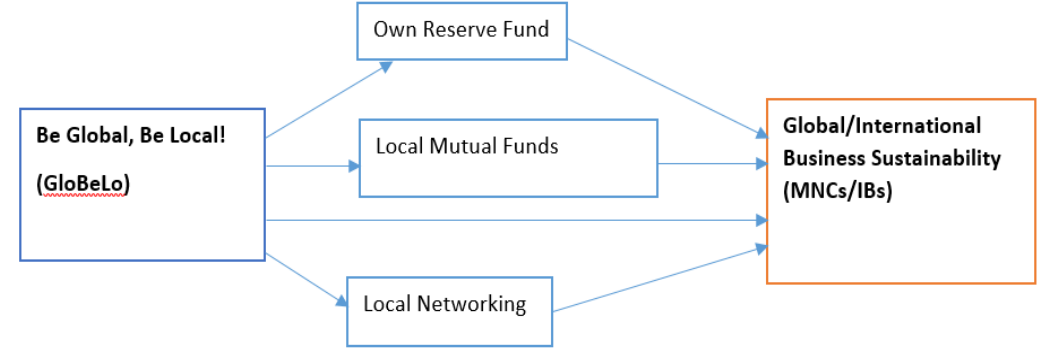
Figure 2 . Path Model for International/Global Business Sustainability in Hardship (Pandemic). Source: Authors’